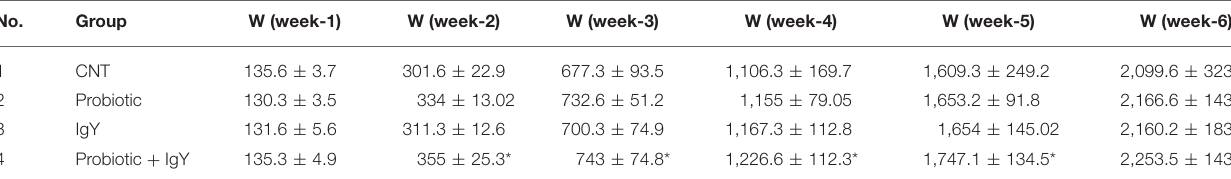
FIGURE 3 | (A) Antibacterial activity of IgY, probiotic, and the mixture of both, at different concentrations, against Listeria monocytogenes . (B) Log 10 of the antibacterial activity for the same groups at two concentrations (750 and 3,000 µ g/ml against L. monocytogenes ). TABLE 2 | The statistics of weights (g) of broilers supplemented with variant feed